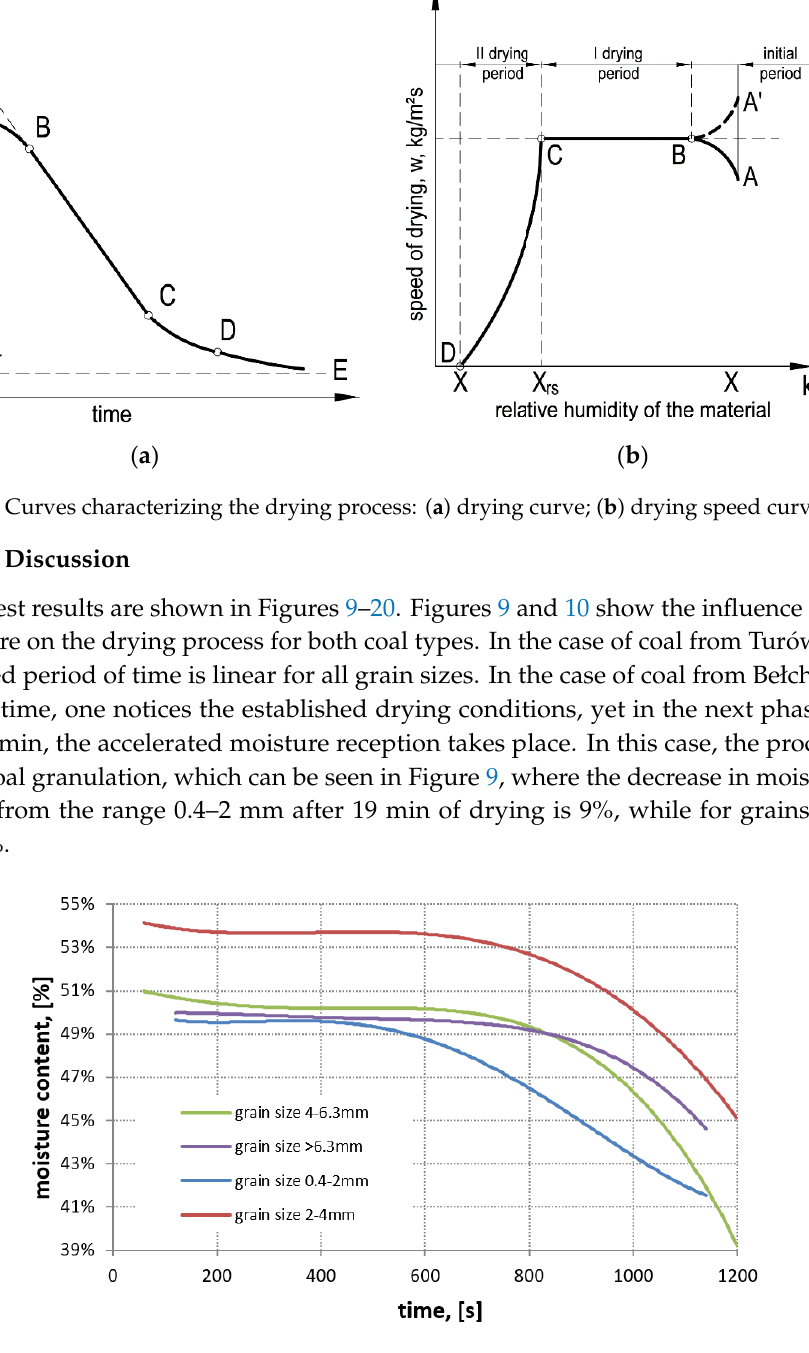
Figure 9. Effect of lignite grain size on the drying process at 35 °C for Bełchatów lignite.